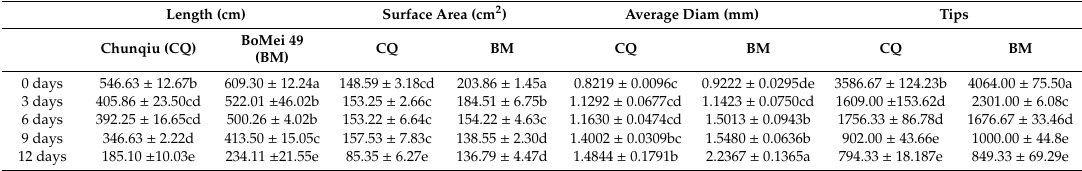
Table 1. E ff ect on root morphological structure 0, 3, 6, 9, and 12 days after treatment with Ca(NO 3 ) 2 stress. The p values marked with similar letters are not significantly di ff erent ( p < 0.05). All the values are the mean of three replicates ± standard deviation (SD).